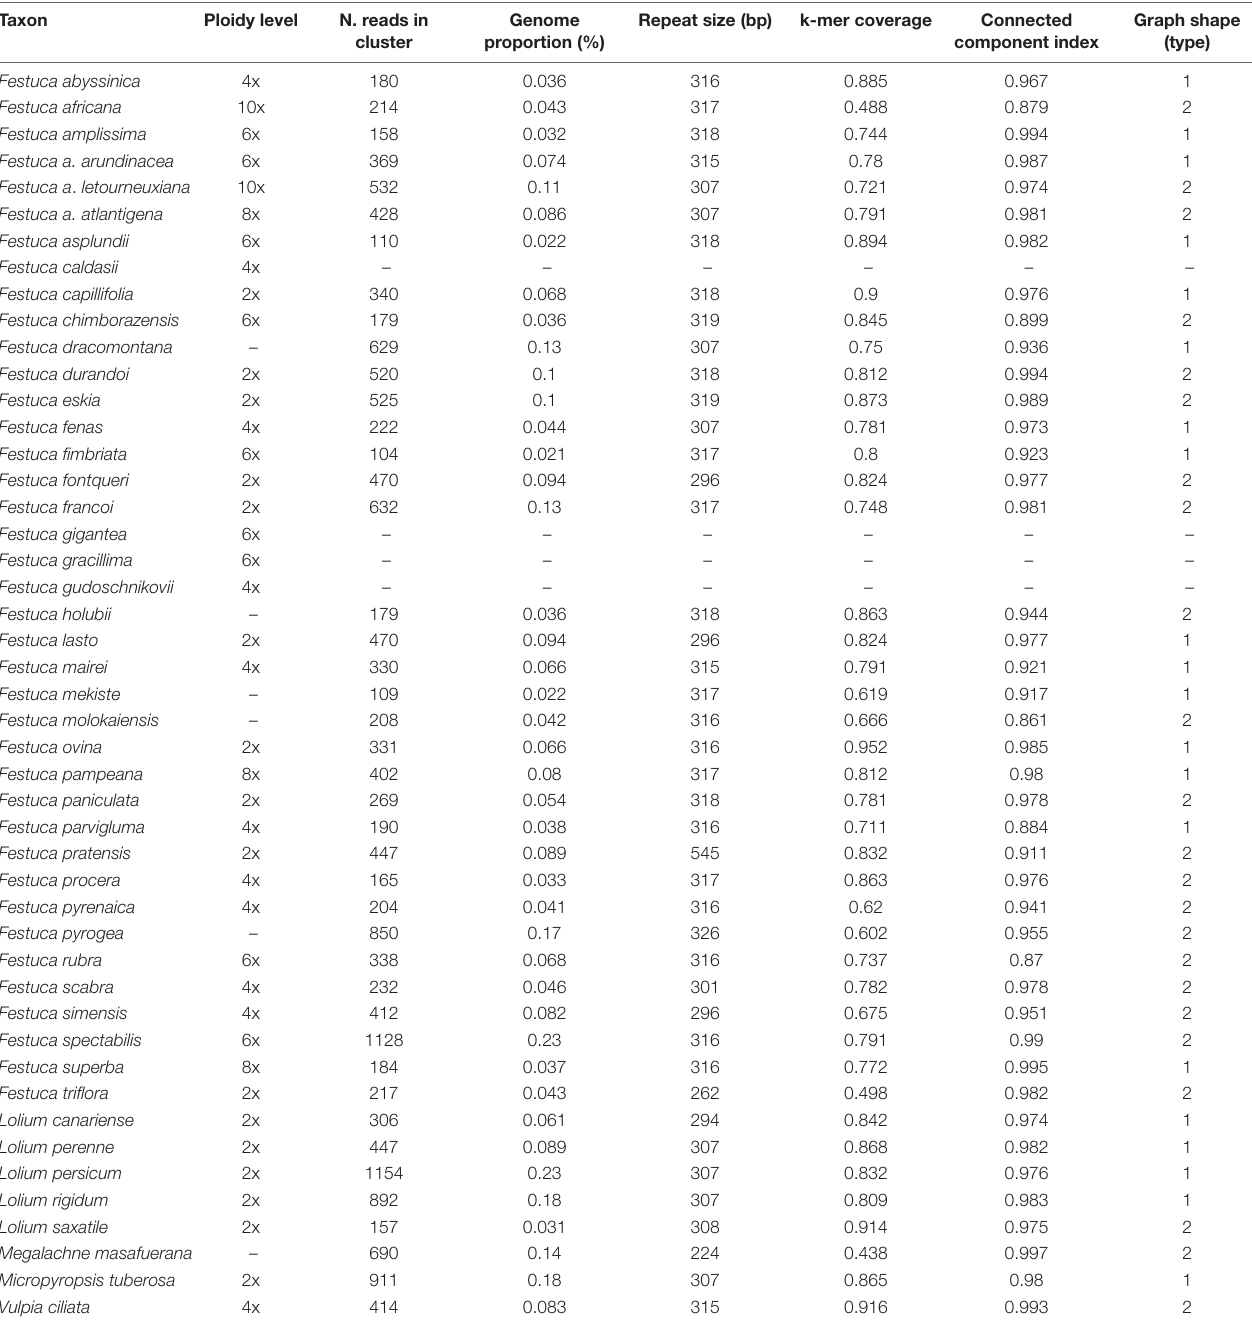
Graph shape types (type 1, simple circular-shaped graph with one loop; type 2, complex graph with two loops where the interconnected loops represent IGS spacers). 5S clustering analysis of F. caldasii, F. gigantea, F. gracillima and F. gudoschnikovii could not be performed due to insufficient number of 5S reads in the clusters. Hyphens, missing